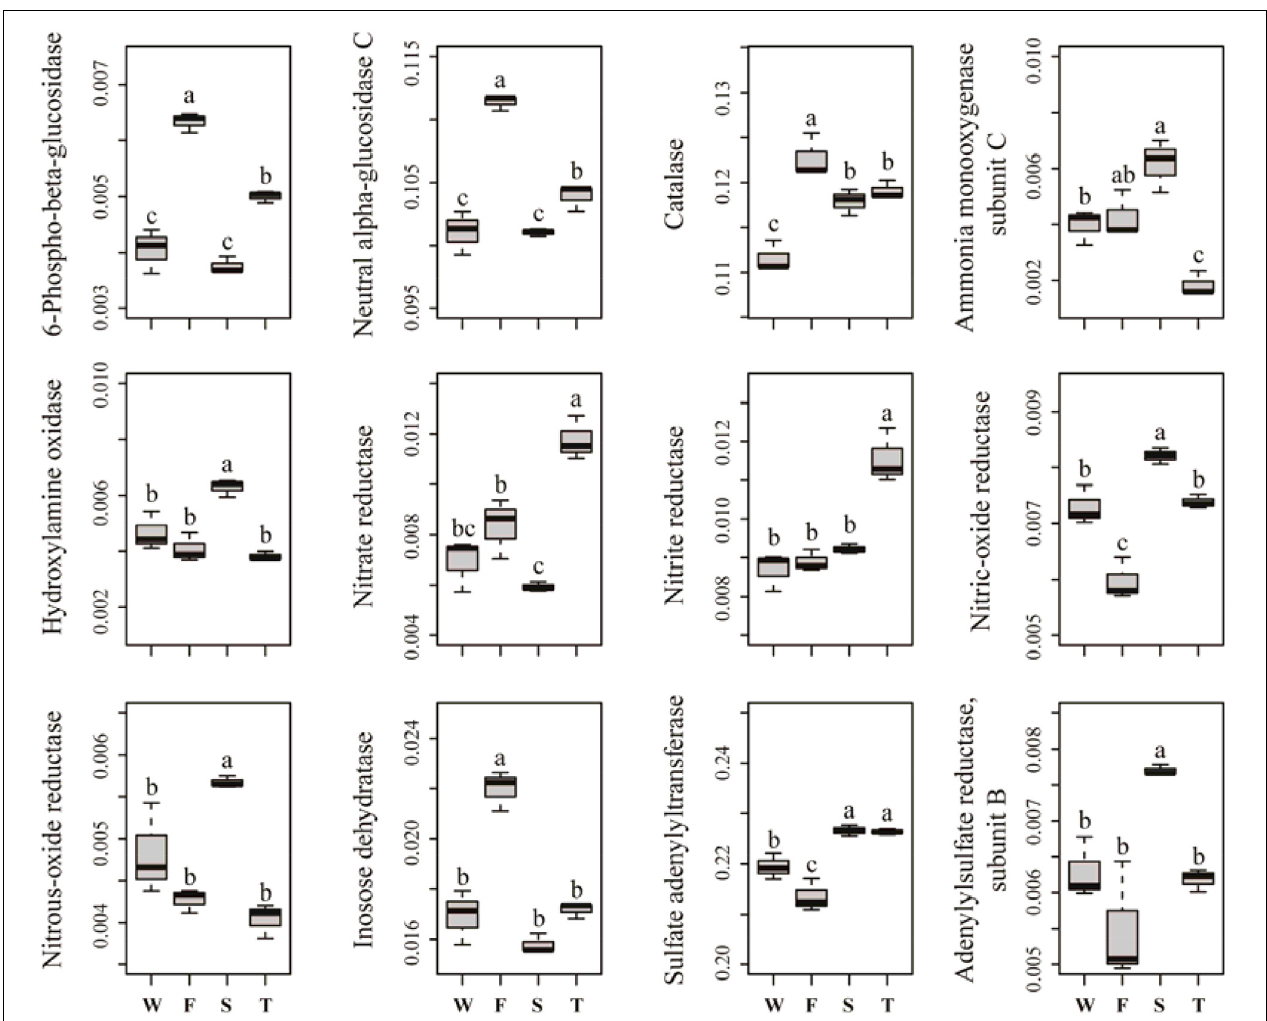
FIGURE 5 | Relative abundances of significantly changed predicted KEGG Orthologs related to carbon, nitrogen, phosphorus, and sulfur cycling. Different letters indicate significant difference based on Kruskal–Wallis test ( P < 0.05). W represents the wheat field; F, S, and T represent the first, second, and third cropping of Jerusalem artichoke (JA),